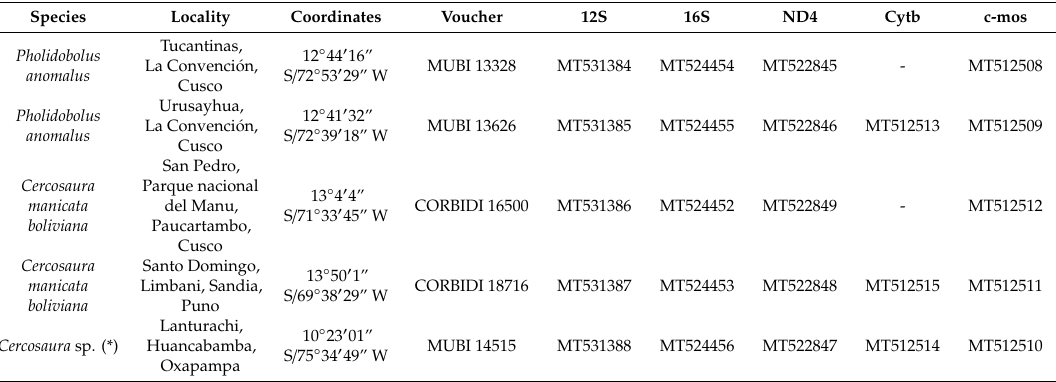
Table 1. Localities (all in Peru), coordinates, voucher numbers, and GenBank accession codes of newly sequenced specimens included in this study. (* described herein)